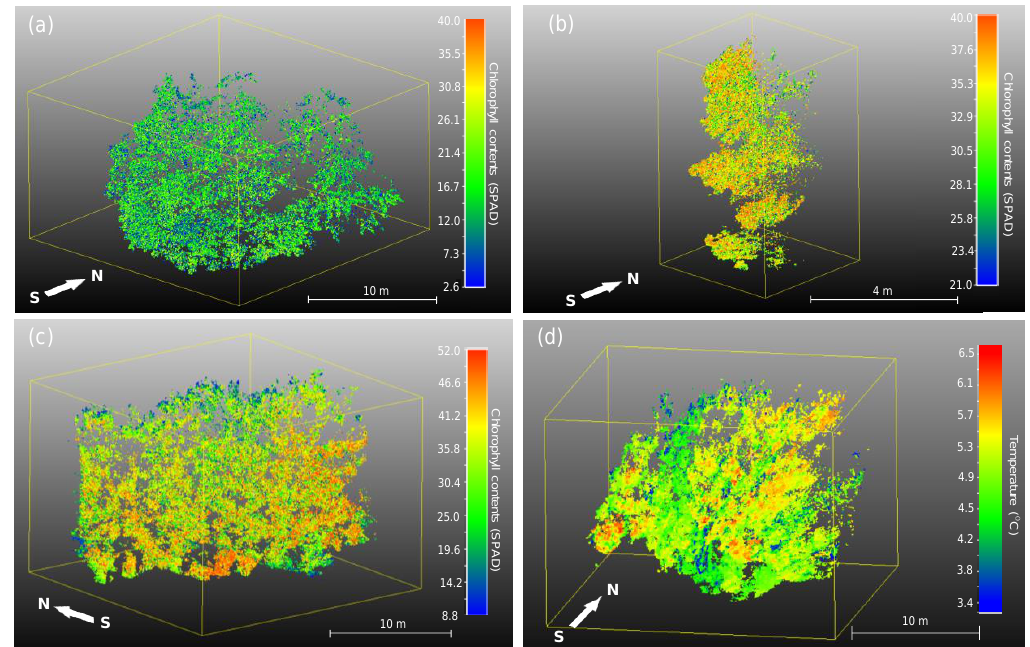
Figure 4. 3D chlorophyll and thermal point cloud images of the samples based on the image fusion between a multispectral camera or thermal camera and a portable scanning lidar. (a), (b), and (c) are the 3D chlorophyll images of sample A, B, and C, respectively, and (d) is a 3D thermal image of sample C. Table 1. Registration errors of the present image fusion method between a 2D multispectral camera or thermal camera images and a 2D projected lidar image. Values in parentheses are errors in the case of the thermal camera and the other values are errors in the case of the multispectral camera. Registration Error Sample Pixel Actual Dimension (m) Mean Max. Min. Mean Max. Min.